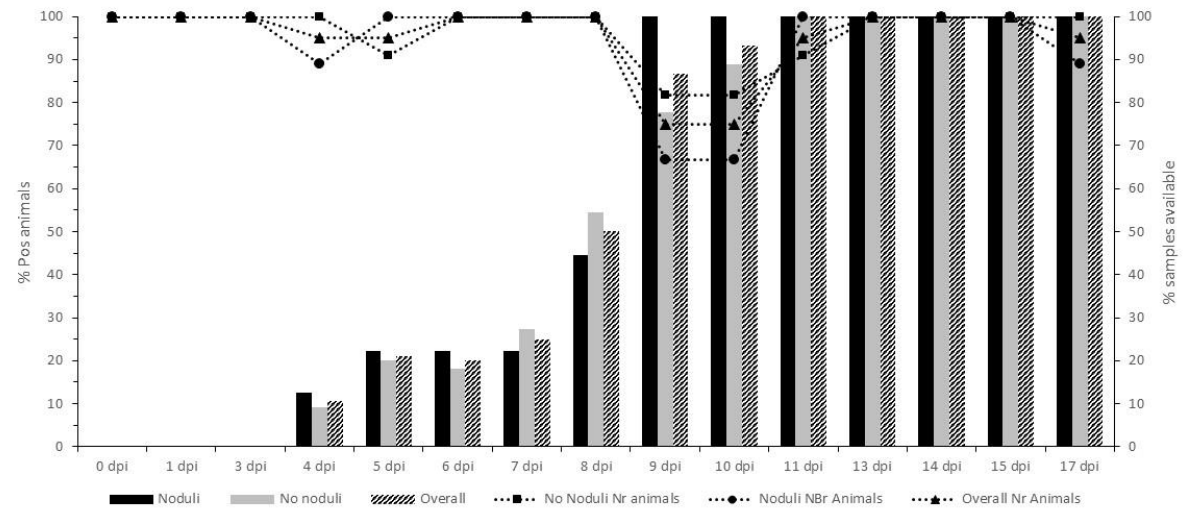
Figure 5. Seroconversion of the control group determined by IPMA. The number of seroconverted animals (in percentage) is displayed in bars, while the percentage of animals sampled is depicted as lines.